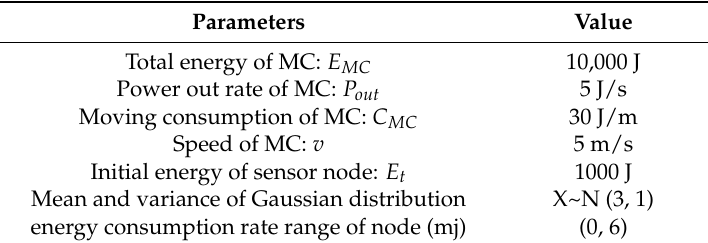
Table 2. Experimental parameter